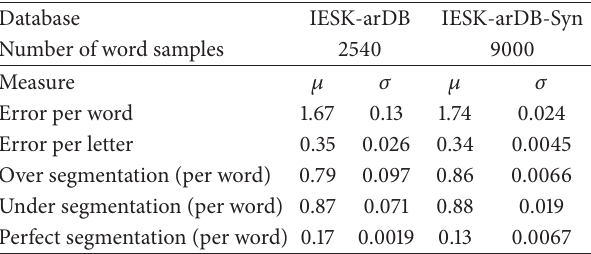
Table 4: Validation of the segmentation